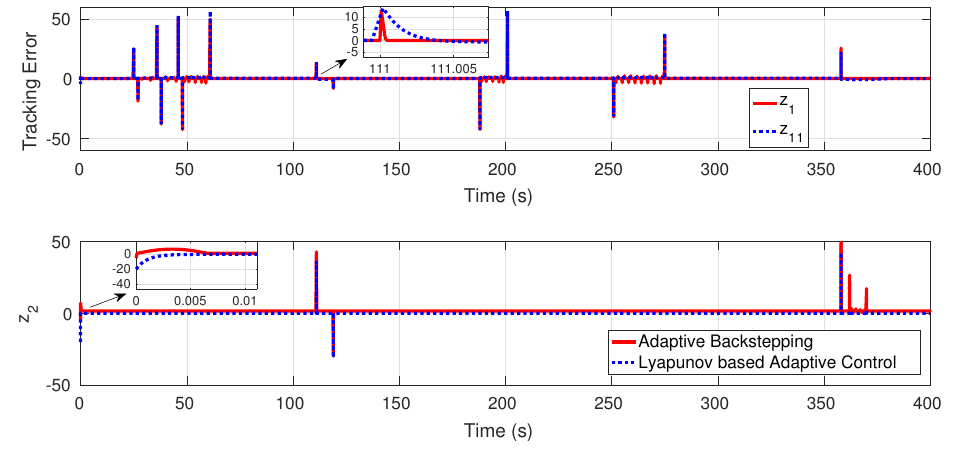
Figure 8. Current tracking error comparison.